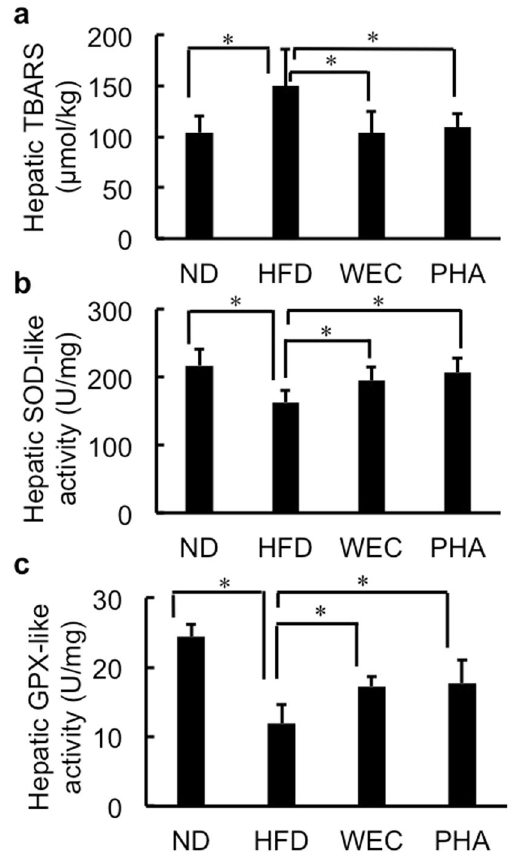
Fig. 3 The effects of WEC and PHA on oxidative stress in liver. Thiobarbituric acid reactive substances (TBARS); ( a ) values ( a ), superoxide dismutase (SOD)-like activity ( b ), glutathione peroxidase (GPX)-like activity ( c ) in the liver of the normal diet-fed (ND), high-fat diet-fed (HFD), Chlorella pyrenoidosa water extract-treated (WEC), and phenethylamine-treated (PHA) groups. Data are represented as mean ± standard deviation ( n = 6). The means were compared using analysis of variance, followed by Dunnett ’ s test. * p < 0.05 vs. HFD group.